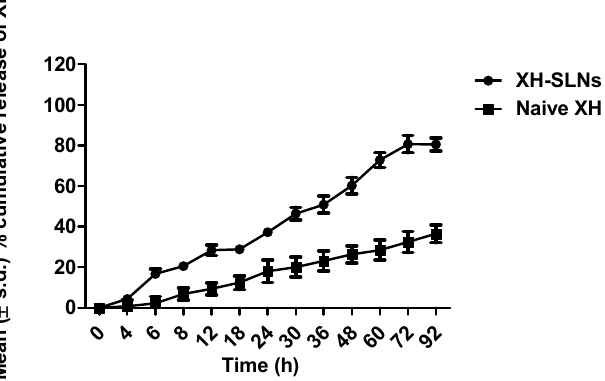
Figure 9. Release profile of naive XH and XH-SLNs.